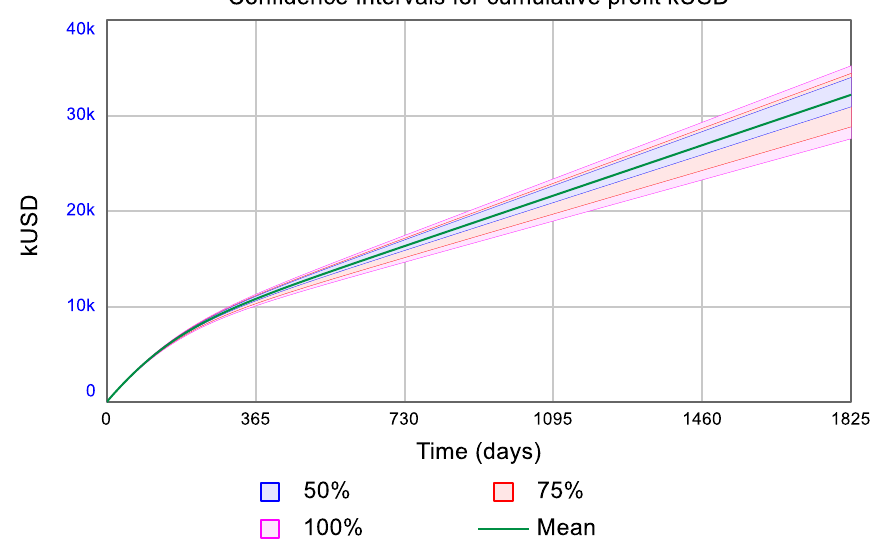
Figure 12. Cumulative profit over five years (1825 days) for different values of the decision times (repair to working, replaced to working, and maintained to working). The mean value and confidence intervals are shown.